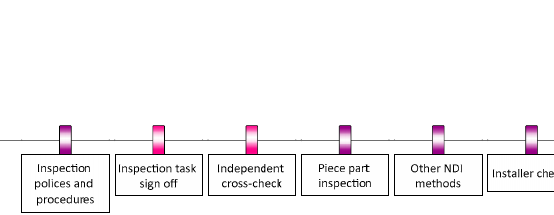
Figure A8. Consequence path with mitigation barriers.